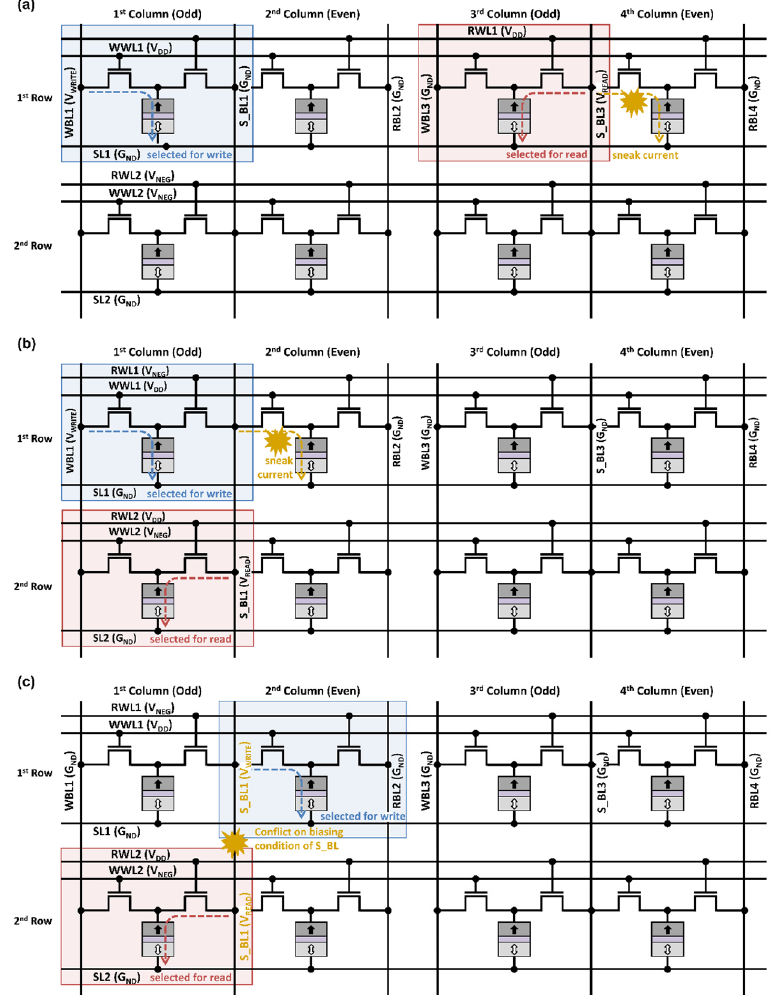
Figure 6. Simultaneous access conflicts by the proposed design: ( a ) Case 1 by simultaneous accesses to a same row, ( b ) Case 2 by simultaneous accesses to a same column, and ( c ) Case 3 by simultaneous accesses to odd-column cell for a write and even-column cell for a read that share S_BL. ( Case 2 ) Accesses to a same column